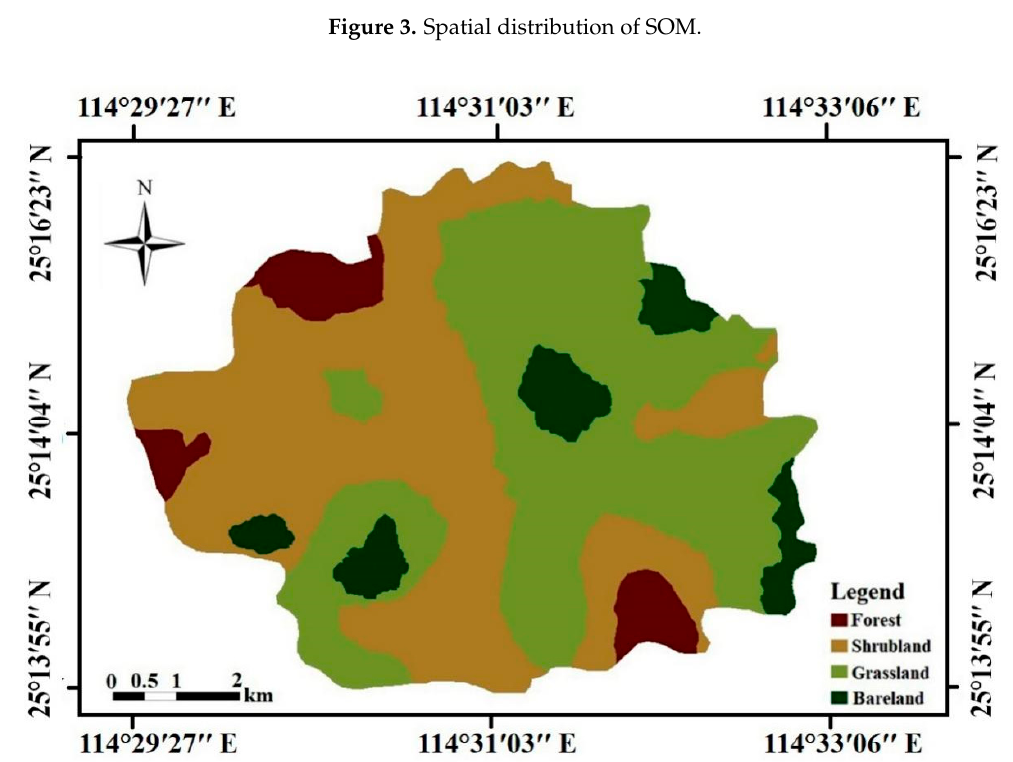
Figure 4. Distribution of different types of land degradation.